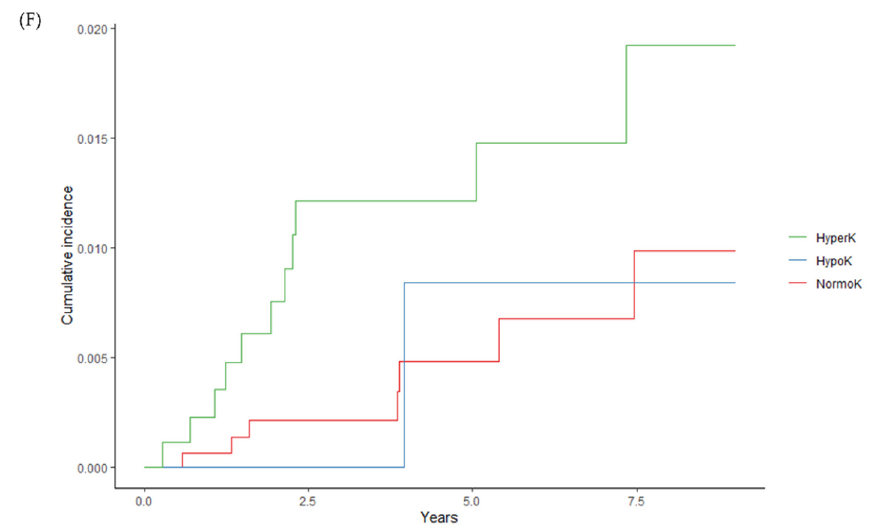
Figure 3. Cumulative incidence of clinical outcomes in Hyper-K, Hypo-K, and Normo-K. ( A ) All- cause mortality in Hyper-K ( p = 0.900), Hypo-K ( p < 0.001), and Normo-K; ( B ) MACE in Hyper-K ( p = 0.700), Hypo-K ( p < 0.001), and Normo-K; ( C ) hospitalization in Hyper-K ( p = 0.018), Hypo-K ( p = 0.381), and Normo-K; ( D ) cardiac arrest in Hyper-K ( p = 0.201), Hypo-K ( p = 0.364), and Normo-K; ( E ) fatal arrhythmia in Hyper-K ( p = 0.827), Hypo-K ( p = 0.214), and Normo-K; ( F ) death related to arrhythmia in Hyper-K ( p = 0.040), Hypo-K ( p = 1.000), and Normo-K. As evaluation of p-values, log-rank testing was used for all-cause mortality, MACE, and death related to arrhythmia, whereas the Fine and Gray test was used for hospitalization, cardiac arrest, and fatal arrhythmia. Table 2. Association between serum potassium status and clinical outcomes in outpatients. Hazard Ratio (95% C.I.) N 100 Person-Year Crude Adjusted a